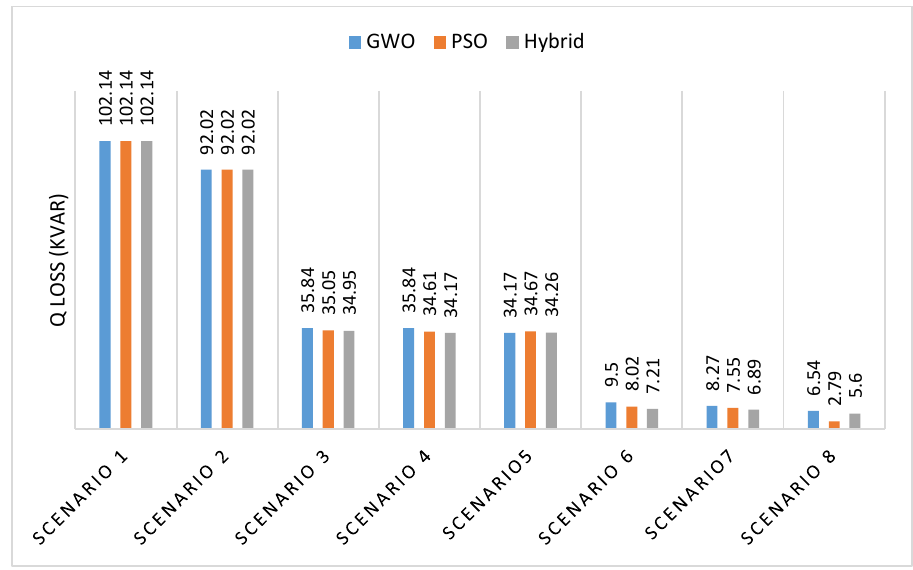
Figure 10. Reactive loss of the 69-bus system using three different techniques.